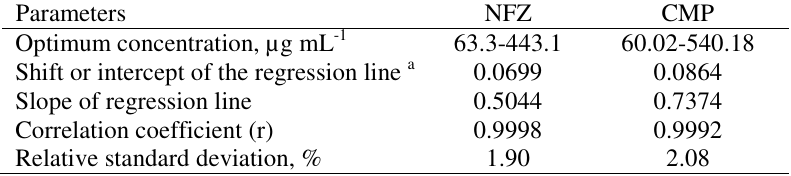
Table 3. Analytical characteristic of conductometric